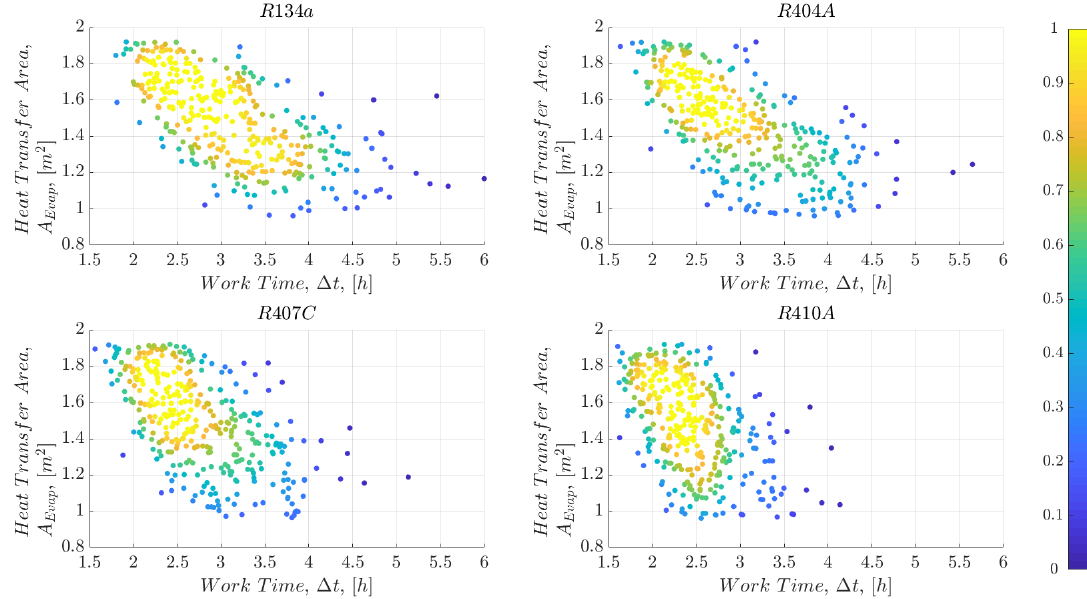
Figure 21. Probability density estimation of the optimization products for all refrigerants.